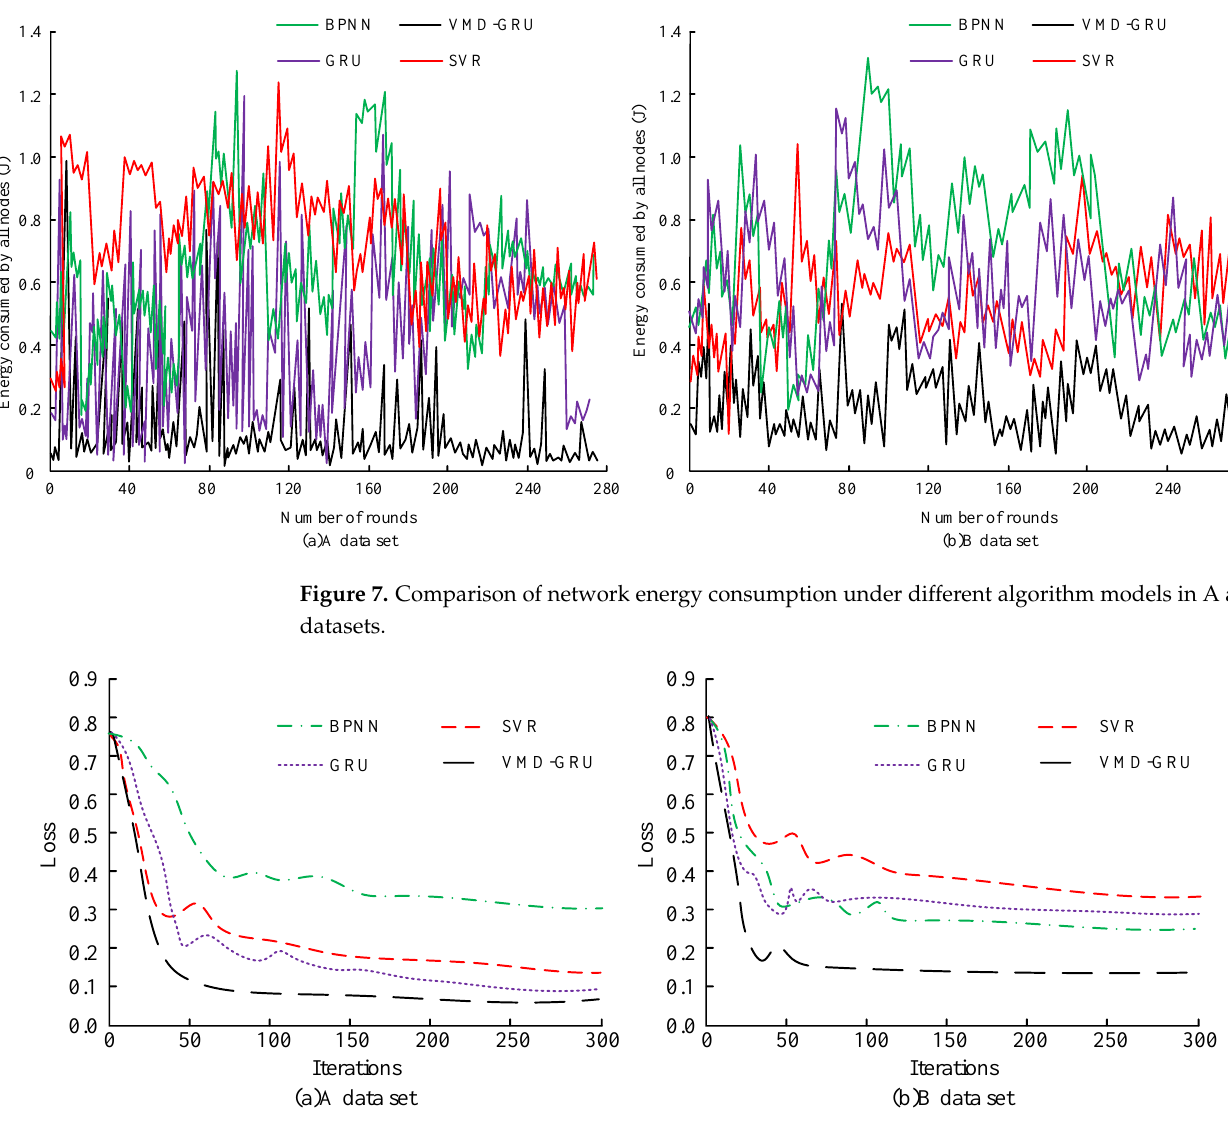
Figure 8. Comparison of loss values of different algorithm models in A and B datasets.